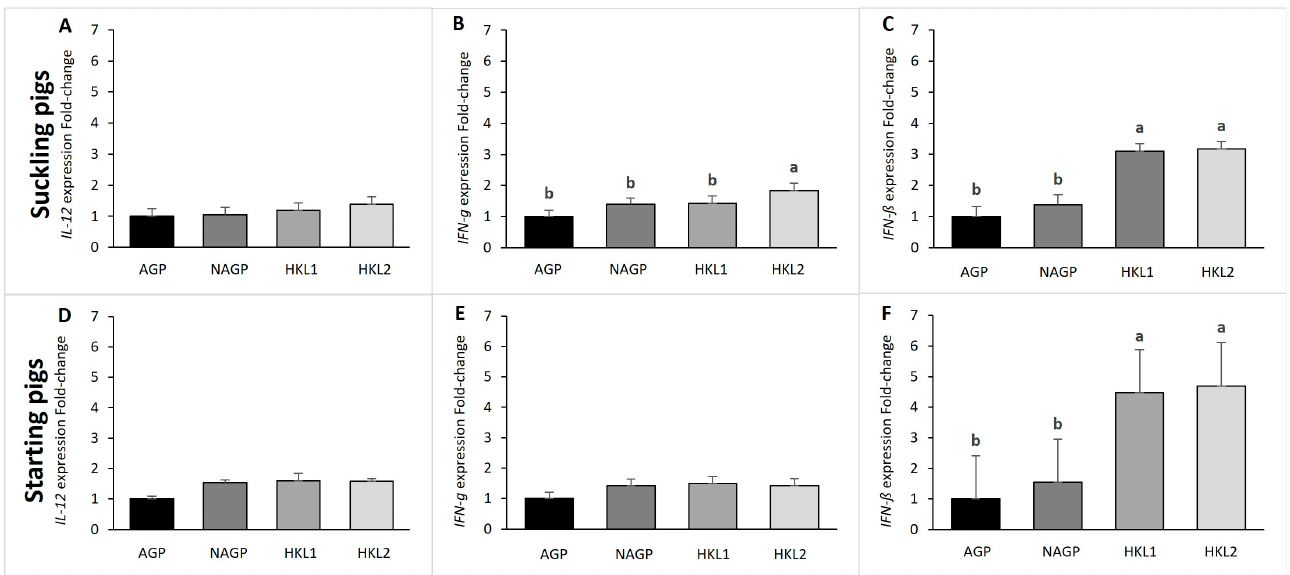
Figure 1. Effects of the dietary treatments on relative gene expression in the pigs at the end of the suckling phase (24 days old; ( A ) = IL-12 , ( B ) = IFN- γ , ( C ) = IFN-ß ) and the starter phase (73 days old; ( D ) = IL-12 , ( E ) = IFN- γ , ( F ) = IFN-ß ). AGP = basal feeds supplemented with antibiotics as a growth promoter (amoxicillin and colistin) at 300 ppm from the suckling to the grower phase; NAGP = basal feeds without AGP or any feed additive from the suckling to the finisher phases; HKL1 = basal feeds supplemented with HK L-137 at 20, 20, 20, 0, 0, and 0 ppm; and HKL2 = basal feeds supplemented with HK L-137 at 20, 20, 4, 4, 4, and 0 ppm during the suckling phase, weaner phase, starter phase, grower phase, finisher 1 phase, and finisher 2 phase, respectively. ab Means with different superscripts differ significantly ( p < 0.05). SEM is the standard error mean. IL-12 = Interleukin-12 , IFN-ß = Interferon- β , IFN- γ = Interferon- γ , and ß-actin = Beta actin (control gene)